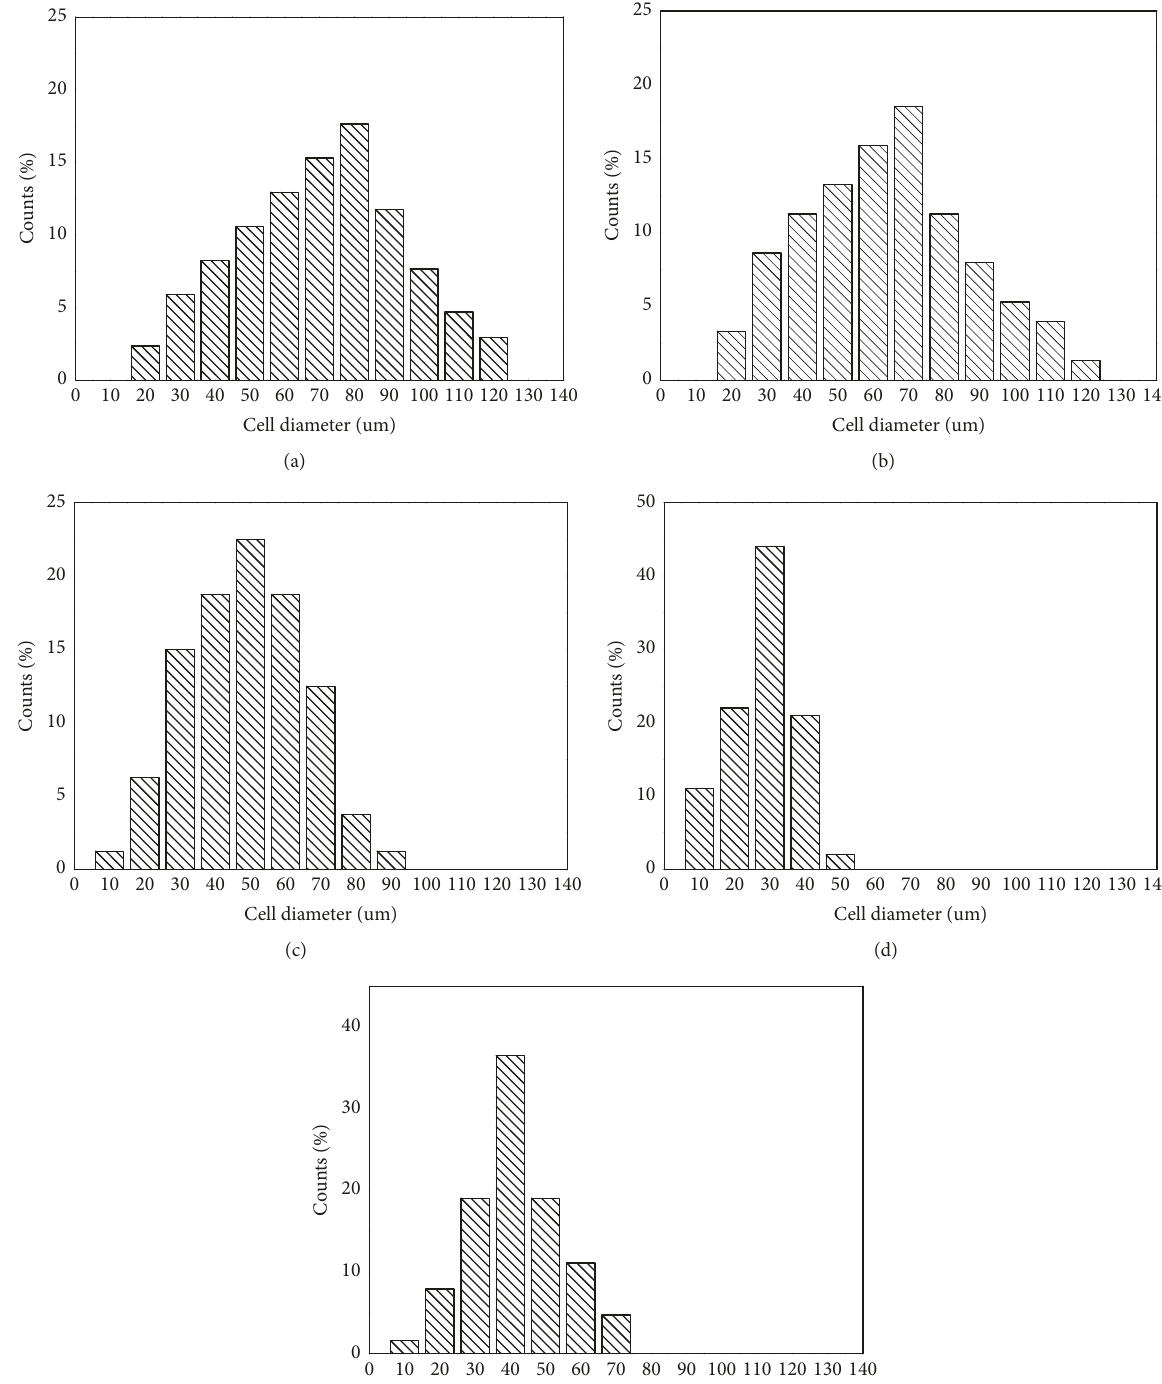
Figure 5: Pore diameter distribution of SFM/NBR-PVC microcellular foaming materials: (a) 0wt%, (b) 10 wt%, (c) 20 wt%, (d) 30 wt%, (e)